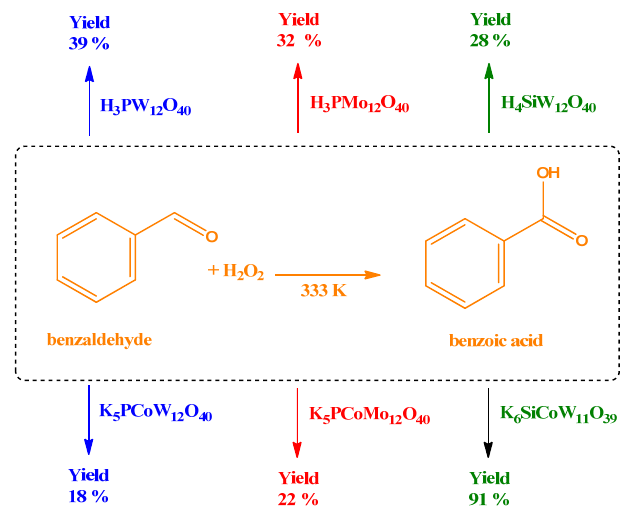
Figure 15. Conversions and selectivity achieved on the borneol oxidation with hydrogen peroxide over transition metal cations -doped potassium silicotungstate salts (adapted from ref. [42]). Only the nickel and iron-doped potassium silicotungstate salts achieved a camphor yield equal or superior to that reached by the lacunar potassium silicotungstate salt. How- ever, while the K 8 SiW 11 O 39 -catalyzed reaction a tt ained the maximum conversion after 2 h of reaction, in the presence of the K 6 SiW 11 NiO 39 catalyst it was achieved within the fi rst hour of reaction. Interestingly, when the copper acted as a countercation of silicotungstate salt, it was the best catalyst in furfural oxidation [27]. Herein, as a dopant, the copper was the worst catalyst, achieving the lowest camphor yield on the borneol oxidation (Figure 14) [42].